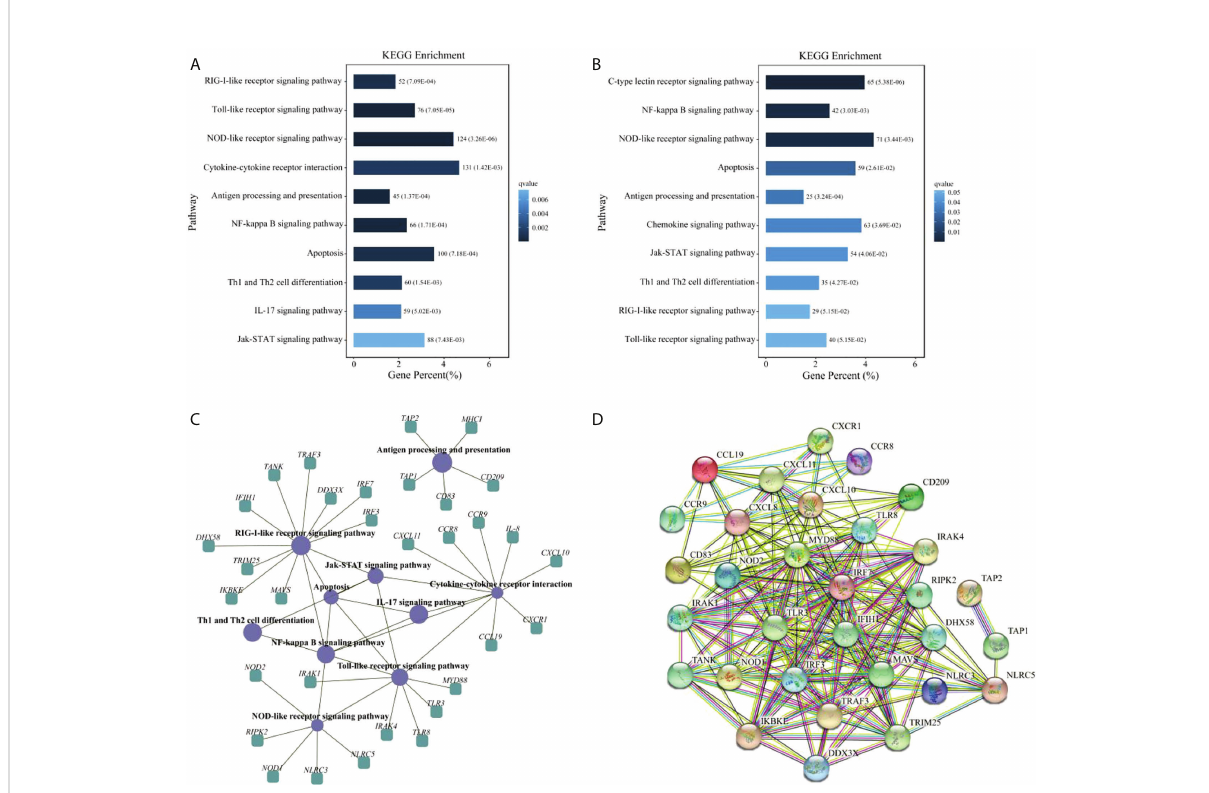
FIGURE 3 Immune system pathways between C48L and T48L groups. (A) Enrichment information of DEGs in immune system pathways. (B) Enrichment information of targets of DEMs in immune system pathways. (C) Enrichment of key immune-related DEGs in corresponding pathways and interaction of immune system pathways. (D) Protein-protein interaction network of immune-related genes obtained in this